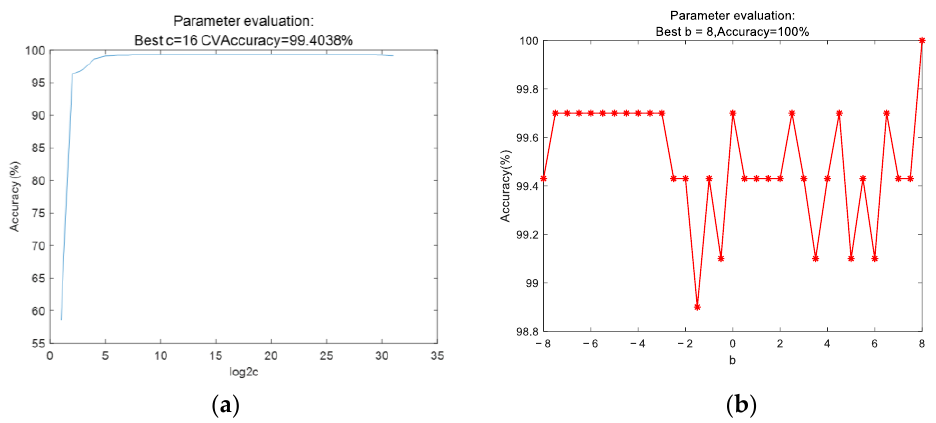
Figure 6. Link quality classification under BW = 500 Khz, SF = 7.